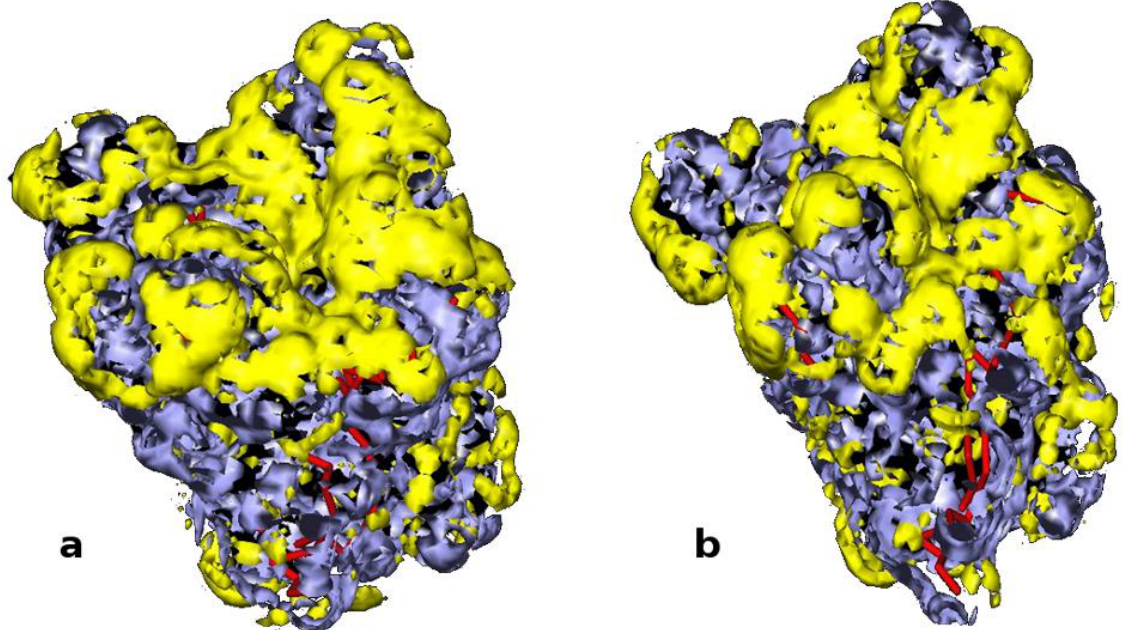
Figure 2. GRID analysis of hydrophobic (yellow) and hydrophilic (blue) surface of PcL. On the left: open conformation corresponding to the crystal structure obtained in the presence of an inhibitor (PDB code 1YS1). On the right: partially closed conformation computed after 20 ns MD simulation in explicit